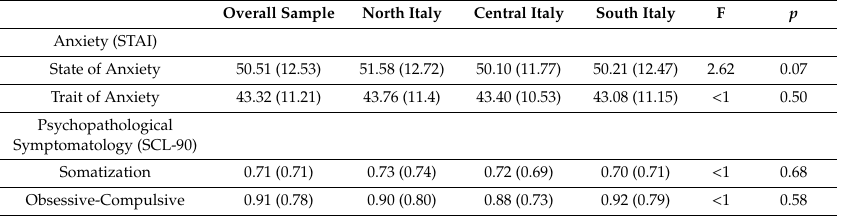
Table 3. Mean and SD of state and trait anxiety (STAI), psychopathological symptomatology (SCL-90) and post-traumatic stress symptomatology (IES-R) outcomes in the di ff erent Italian territorial areas, and ANOVA’s